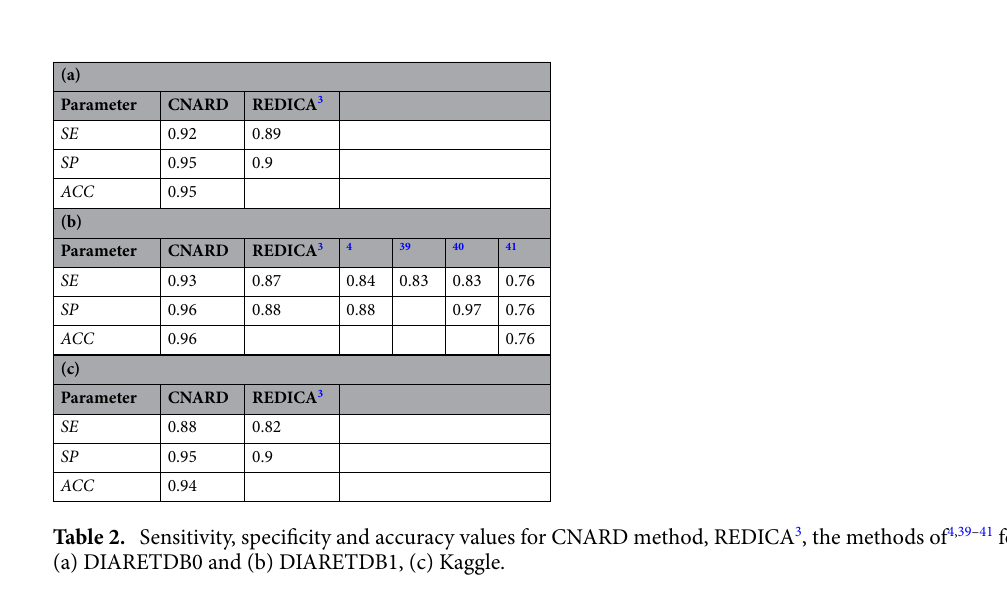
Figure 7. The effect of two values of Intensity_th on the capability of red-lesion detection.